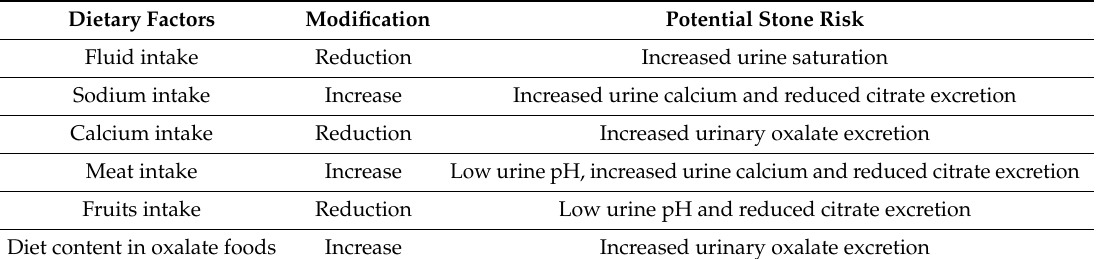
Table 1. Dietary factors and potential stone